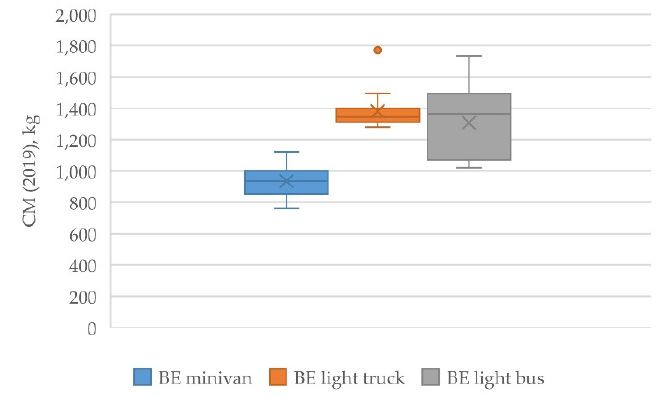
Figure 6. Curb mass (CM) distribution of the various BELVs (2019).